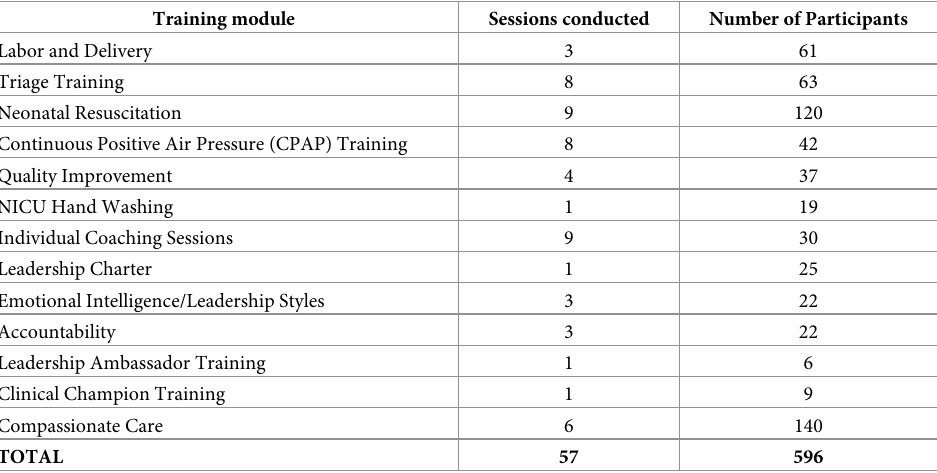
Table 1. Training modules conducted at Greater Accra Regional Hospital,